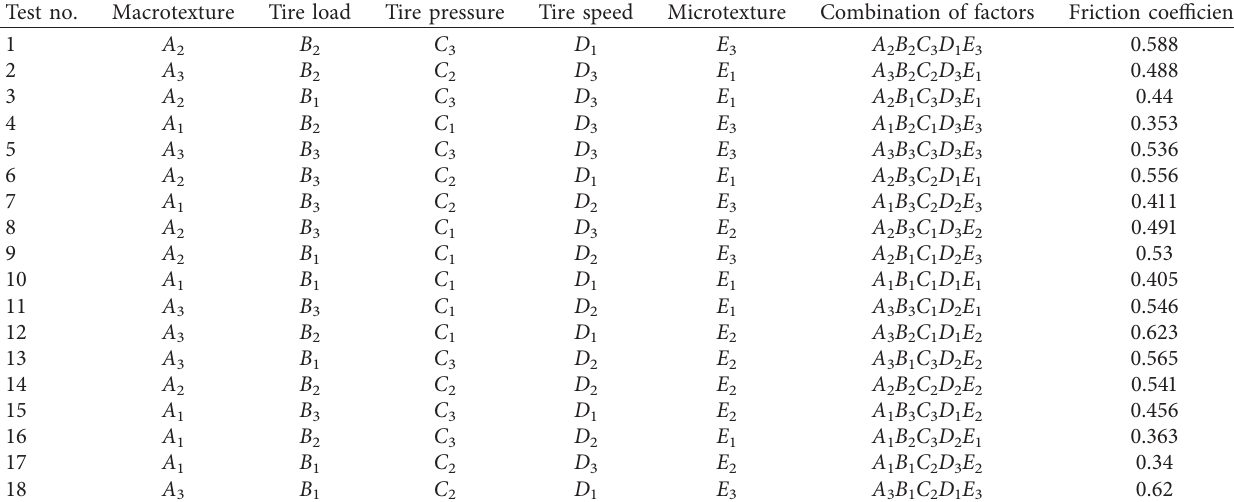
Table 6: The orthogonal test of pavement friction coefficient.